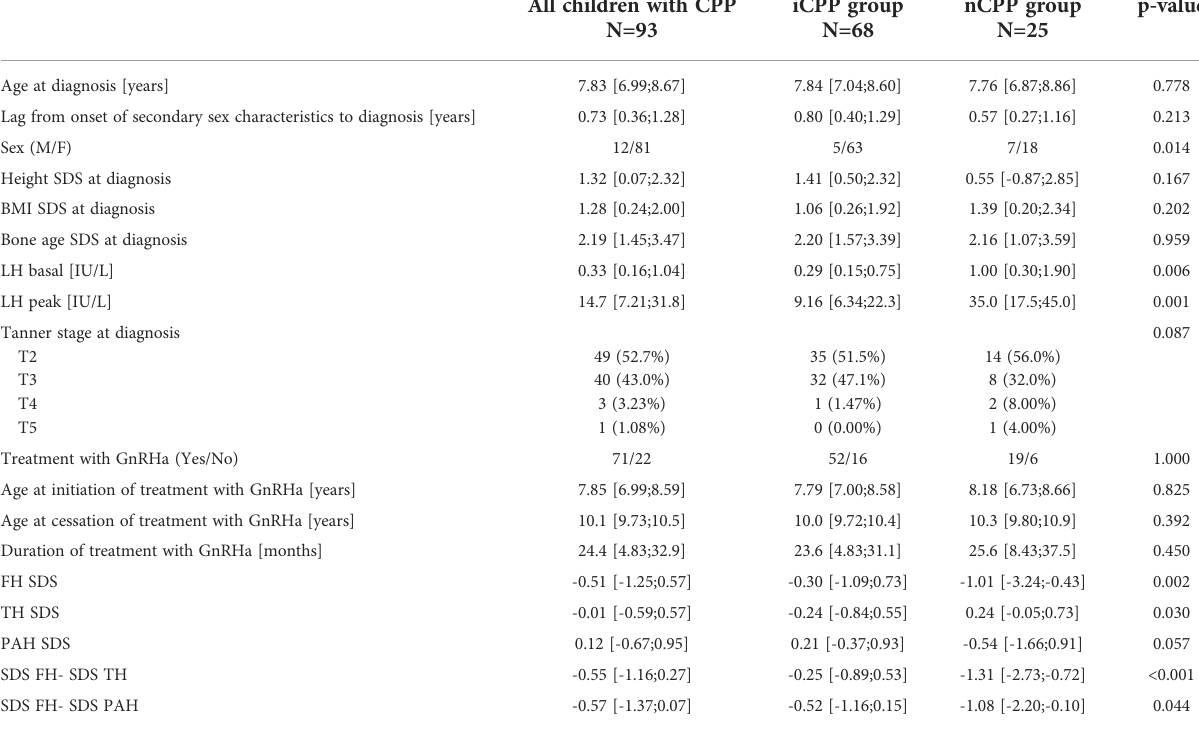
TABLE 2 Comparison between idiopathic and non-idiopathic